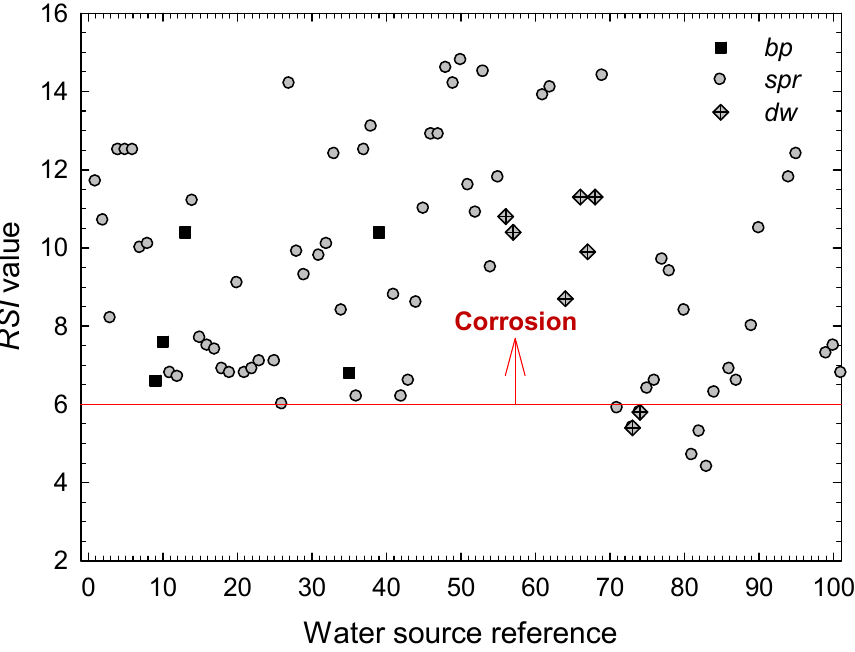
Figure 4. Distribution of the water sources in the Azores archipelago according to their Ryznar Stability Index